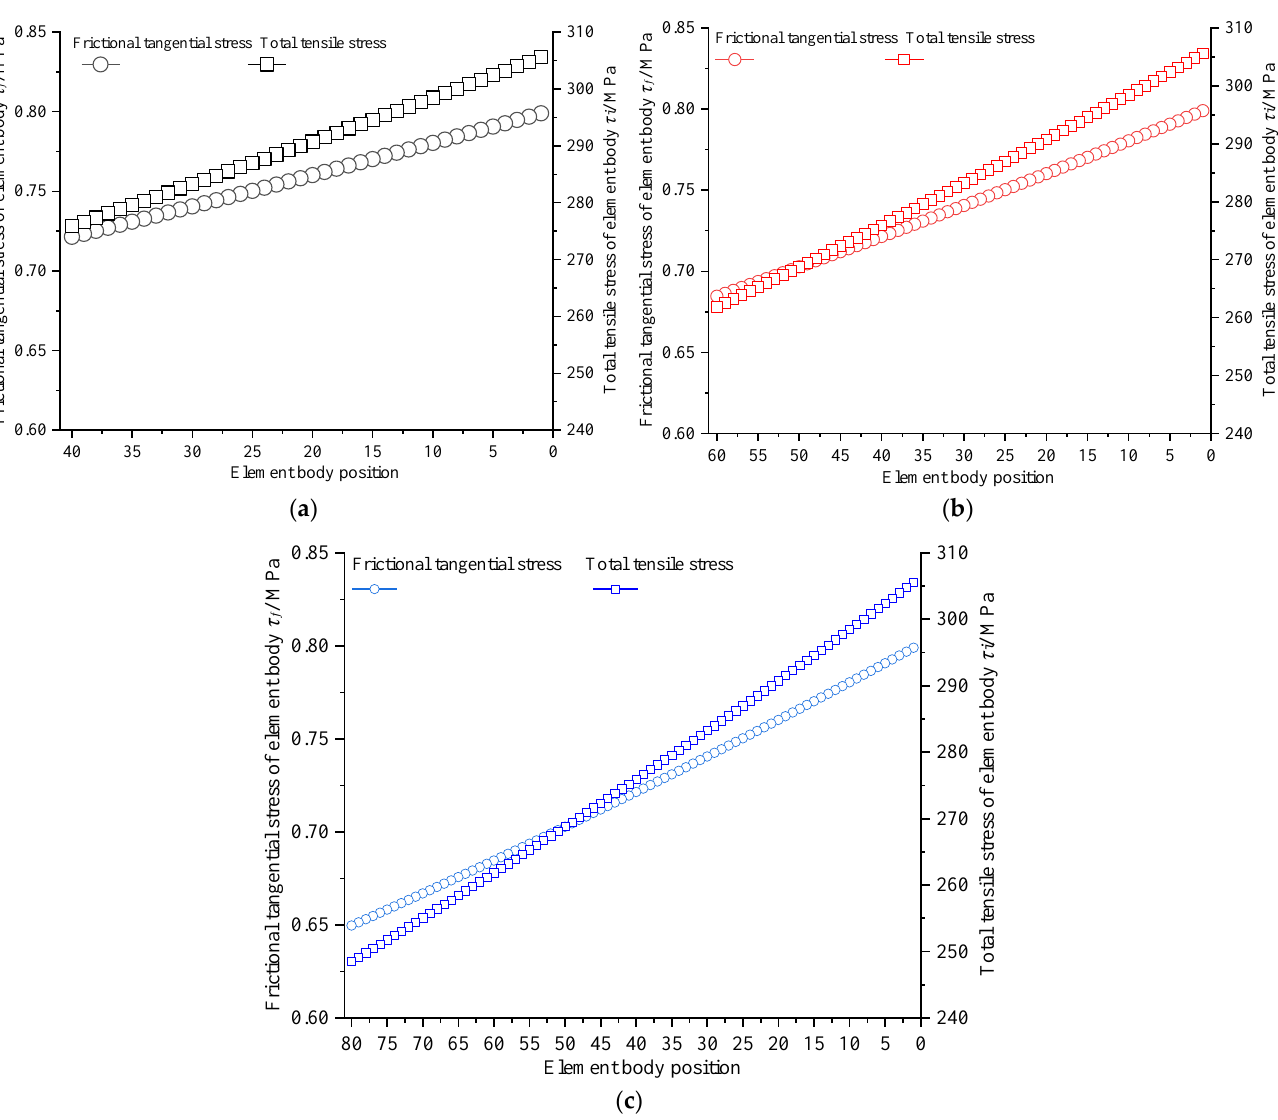
Figure 4. The frictional tangential stress and total tensile stress of each element under different bend angles. ( a ) 30° contact mold; ( b ) 45° contact mold; ( c ) 60° contact mold.